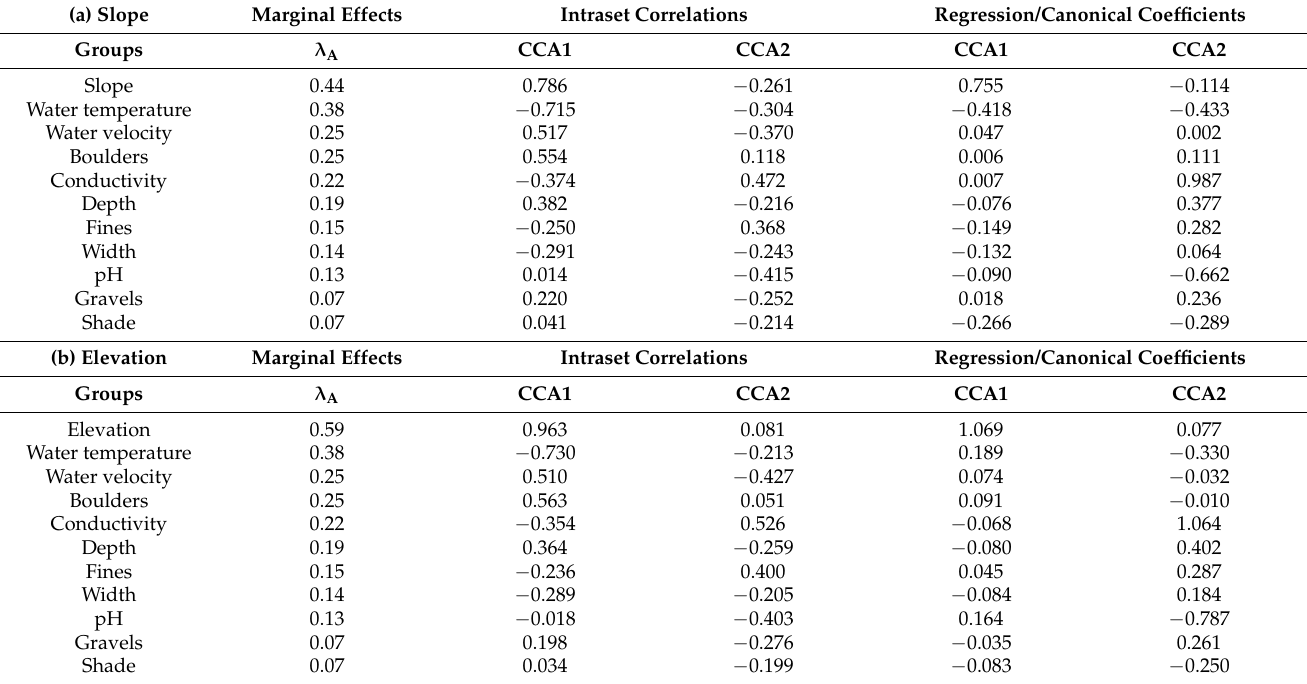
− 1.0 Figure 3. Triplot of results of canonical correspondence analysis carried out with slope ( a ) or elevation ( b ) as key variables related to location, showing site scores (circles), the environmental variables (vectors) and fish abundances (triangles) on the first two canonical axes. The code for site scores and environmental variables refers to sampling sites according to Table 1. Table 3. Results of canonical correspondence analyses (CCA) carried out with slope ( a ) or elevation ( b ) as key variables related to location along the headwater-downstream gradient, showing canonical coefficients and weighted intraset correlation coefficients of explanatory variables with the first two axes of the CCA. Importance of environmental variables using marginal effects are shown λ A